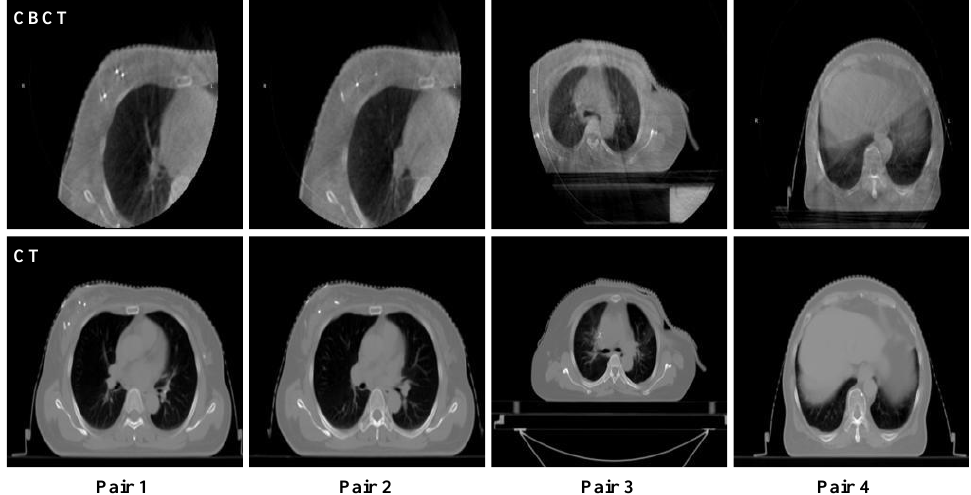
Figure 9. Data used in our experiments (CBCT and CT images of the chest site).